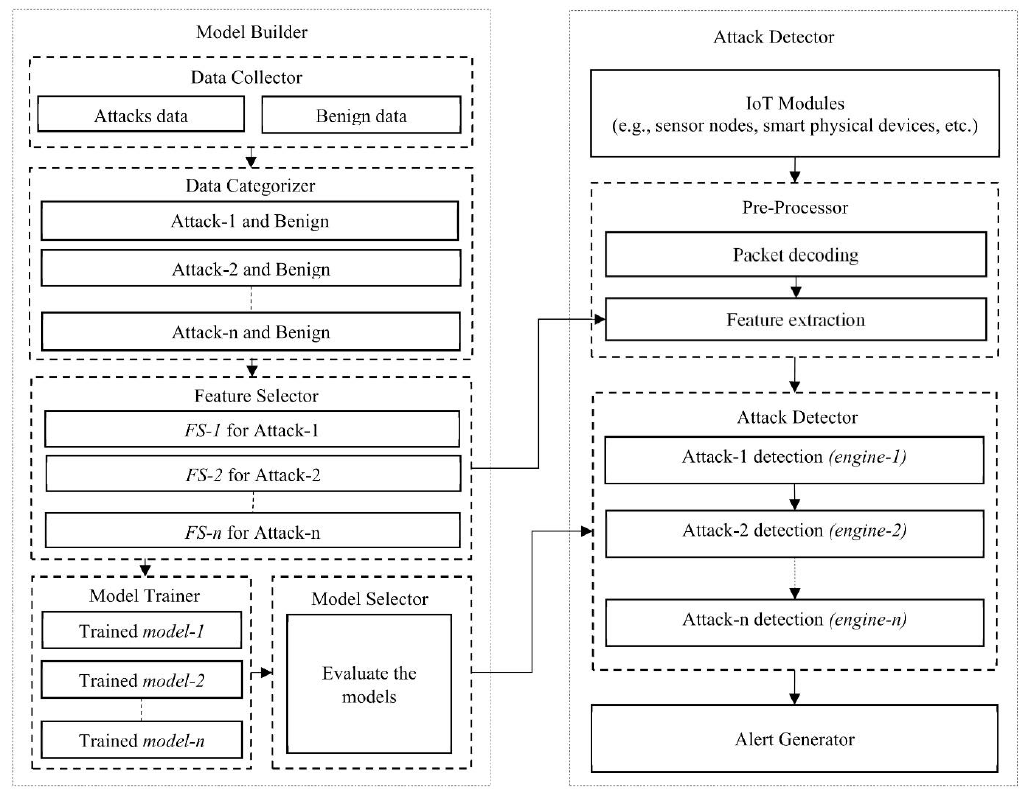
Figure 1. The block diagram of the proposed attack detection architecture.